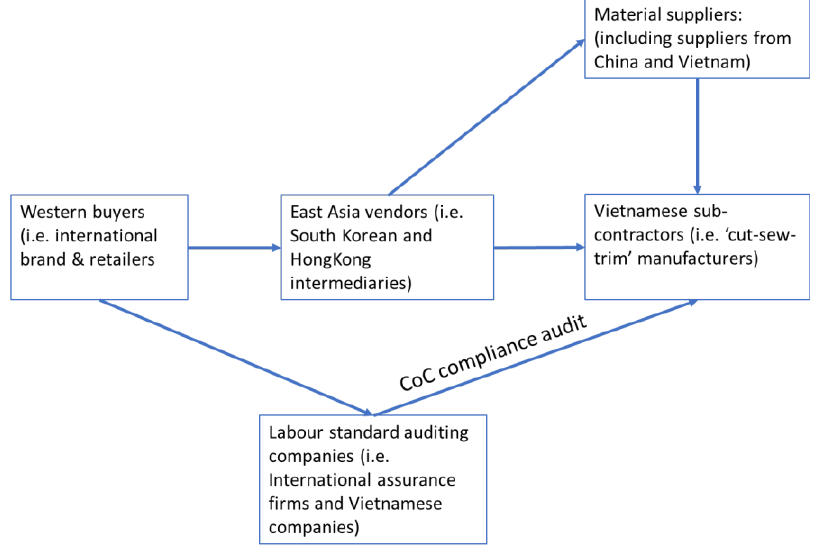
Figure 1. Position of Vietnamese producers in the supply chain.